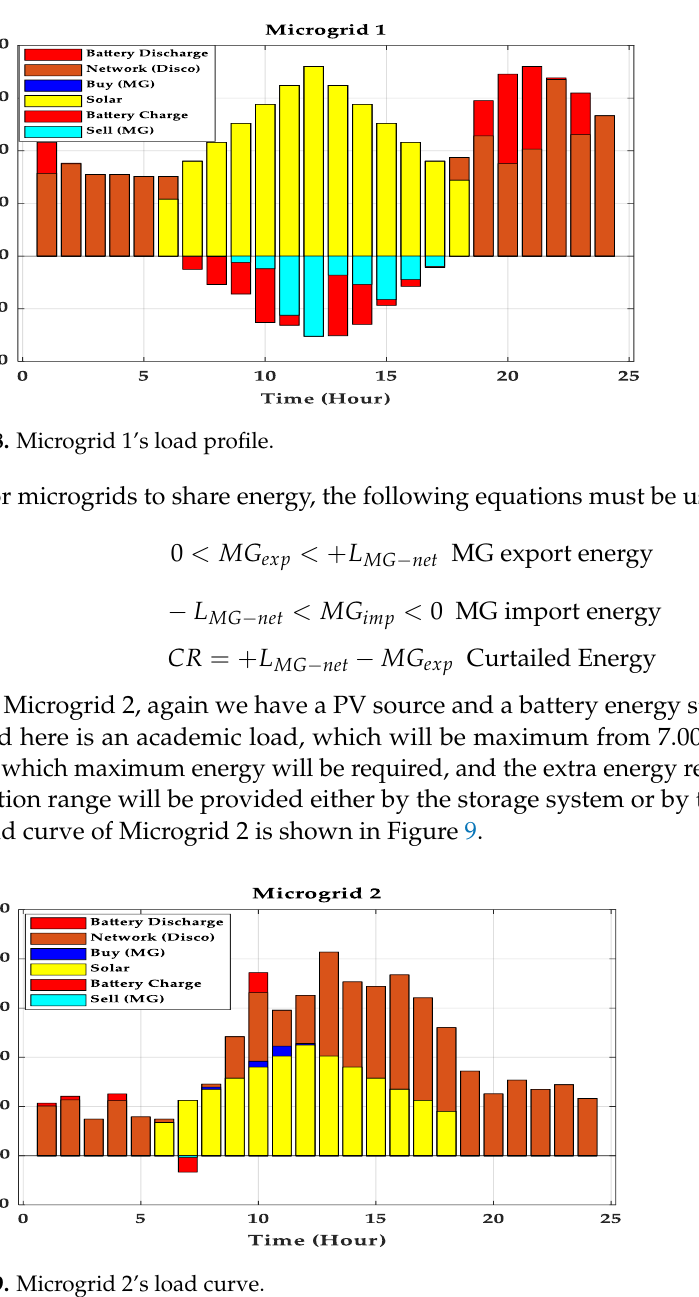
Figure 9. Microgrid 2 ’s load curve.